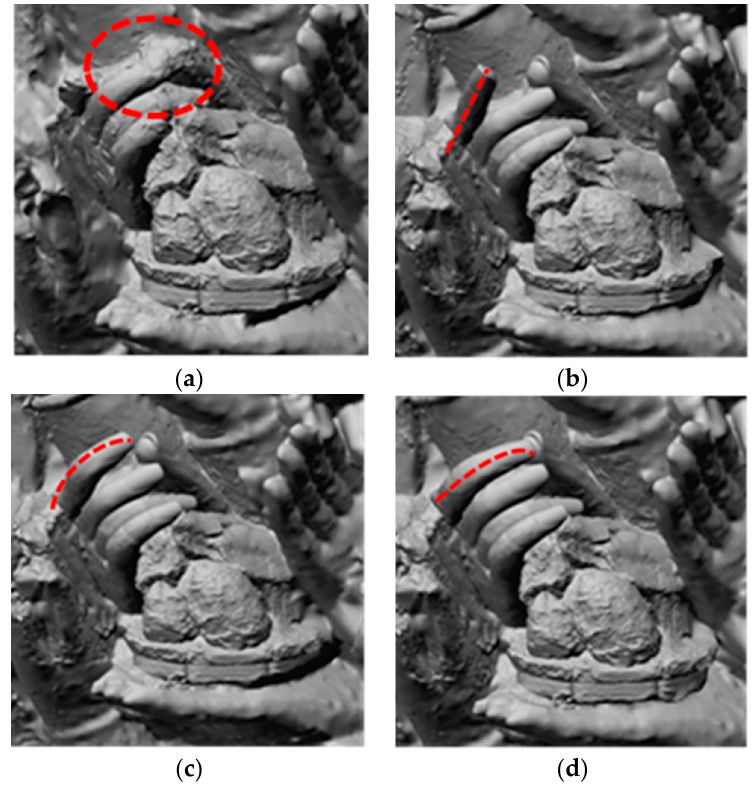
Figure 1. Different restoration results due to lack of reliable restoration evidence: ( a ) damaged finger; ( b ) possible result 1; ( c ) possible result 2; and ( d ) possible result 3.